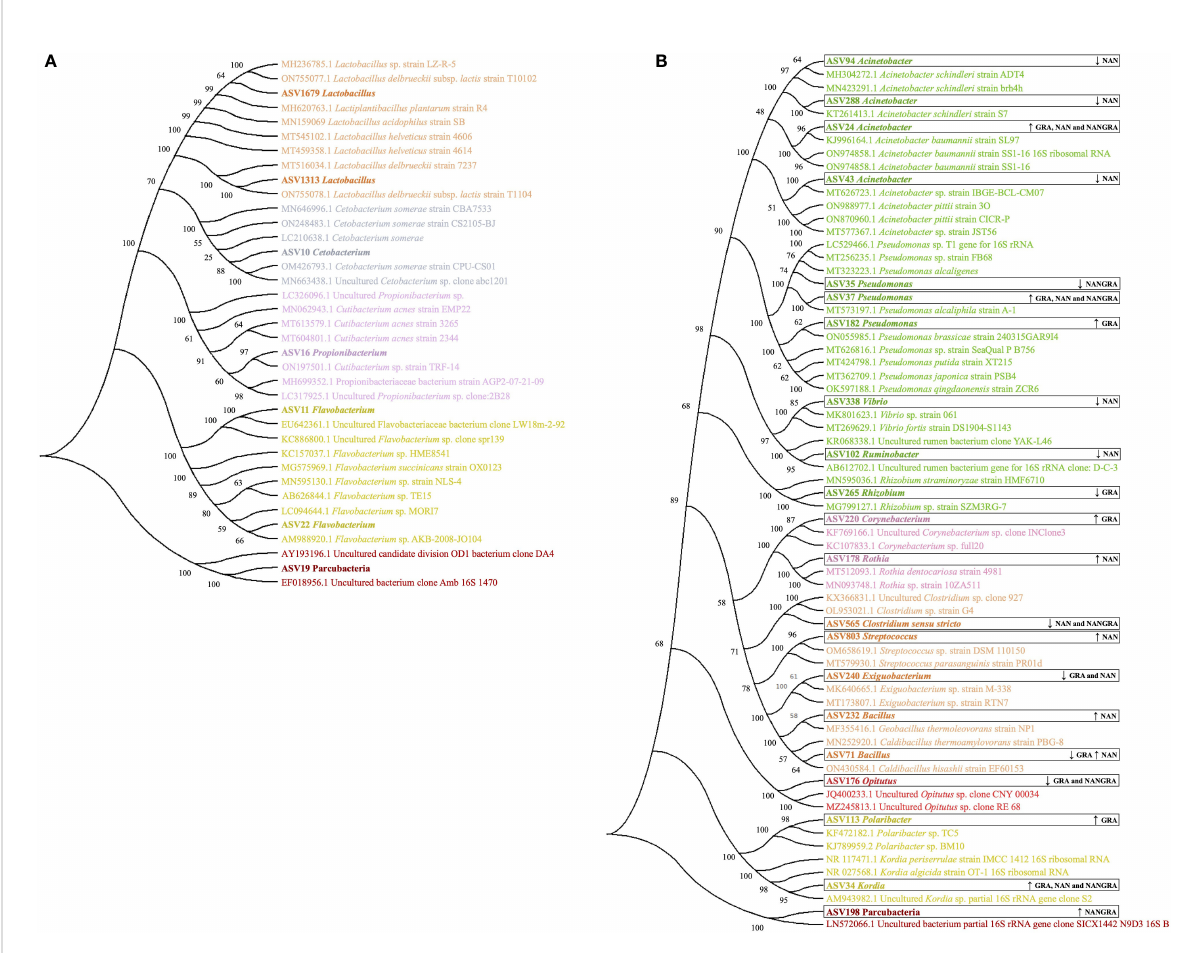
FIGURE 6 Phylogenetic trees generated for the ASVs of interest identi fi ed in the study. (A) ASVs identi fi ed as part of the core microbiome. (B) ASVs identi fi ed as differently abundant in the study groups. ↑ – increase in abundance; ↓ – decrease in abundance; GRA, Gracilaria gracilis group; NAN, Nannochloropsis oceanica group; NANGRA, G gracilis and N. oceanica blend